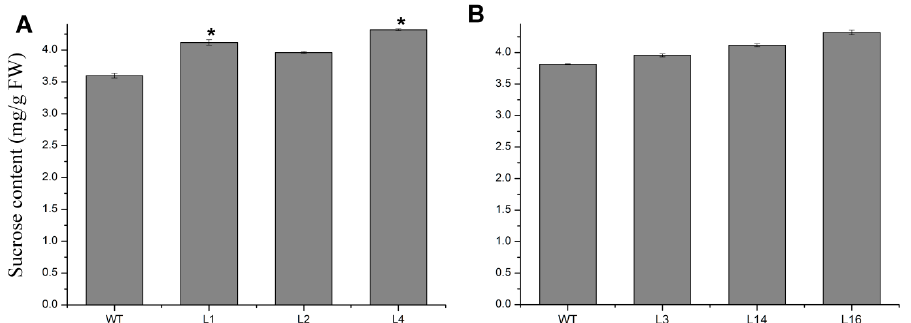
Figure 7. Comparison of sucrose content in the inflorescences between wild ‐ type (WT) and transgenic Arabidopsis lines (L1, L2, and L4) ( A ), and between WT and transgenic Jatropha lines (L3, L14, and L16) ( B ). One-way ANOVA was used to determine significant di ff erences between the transgenic and control plants. FW means fresh weight. * indicates a significant di ff erence at the p < 0.05 level. The error bars represent the standard errors ( n =